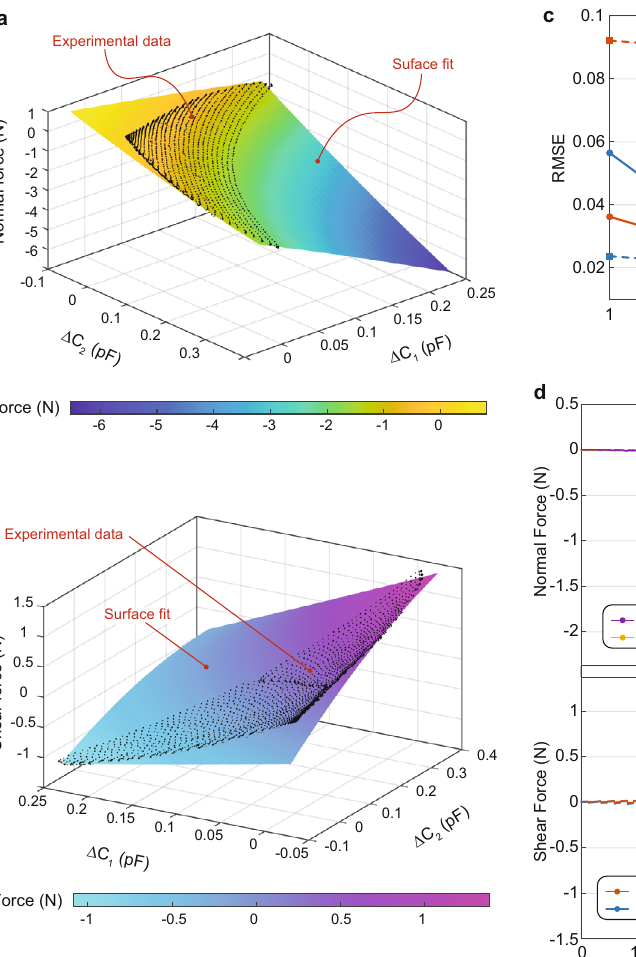
Δ C fi tting method is followed for the shear component where in this 2 . b The same case the shear force is plotted as a function of the capacitance change. c The root mean square error (RMSE in N) of different sensor types are plotted vs. the fi tting order.Based on these results, we choose n = 2 asthe fi tting order. d The shearand normal forces from the load-cell and from the soft sensor showing excellent agreement for both force